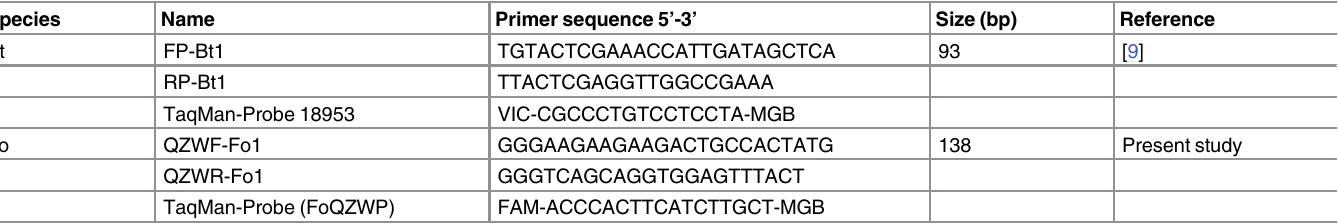
Table 1. Details of primer and probe sequences (5 ’ -3 ’ ), fluorescent labels and expected product size for primers and probes used in duplex qPCR analyses.